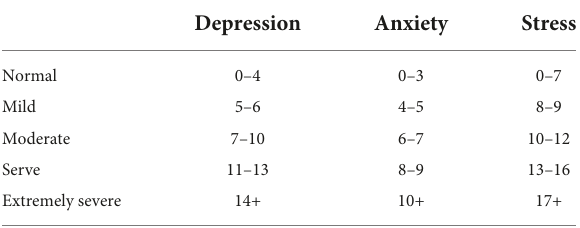
TABLE 1 Cut-off scores for conventional severity labels of depression, anxiety, and stress scale-21 items (DASS-21)